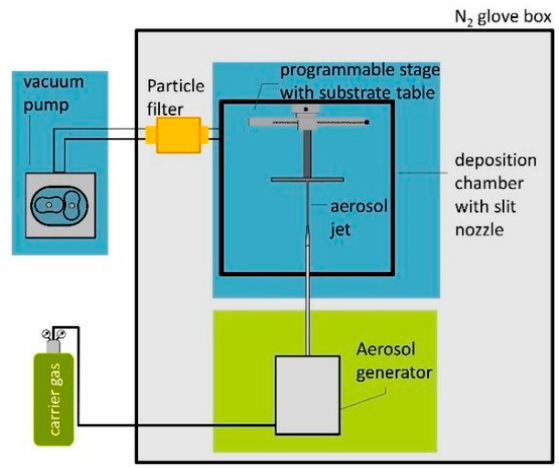
Figure 5. Schematic illustration of typical coating formation using aerosol deposition. Reproduced from [108] with permission of MDPI under the terms and conditions of the Creative Commons Attribution license.